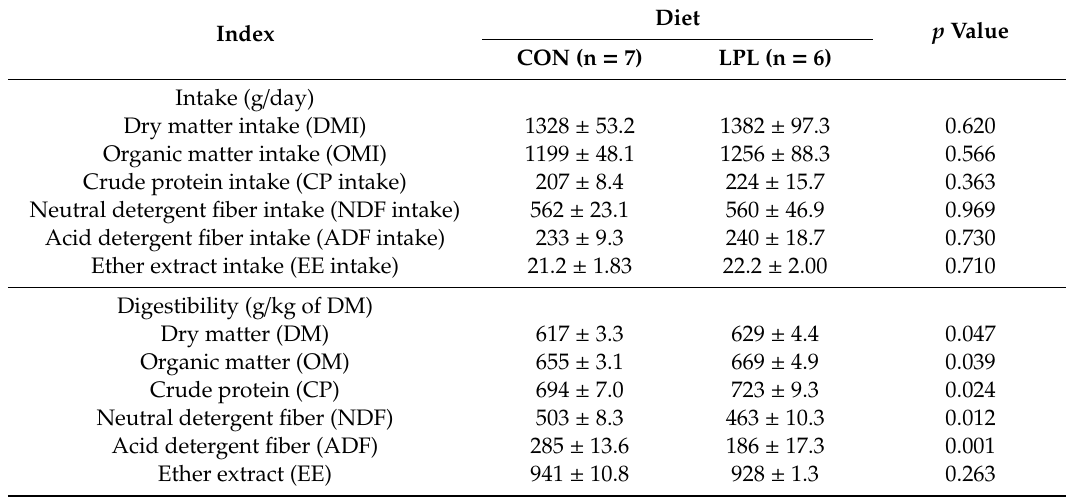
Table 3. Intake and total tract apparent nutrient digestibility of fattening lambs o ff ered a diet supplemented without (CON) or with (LPL)